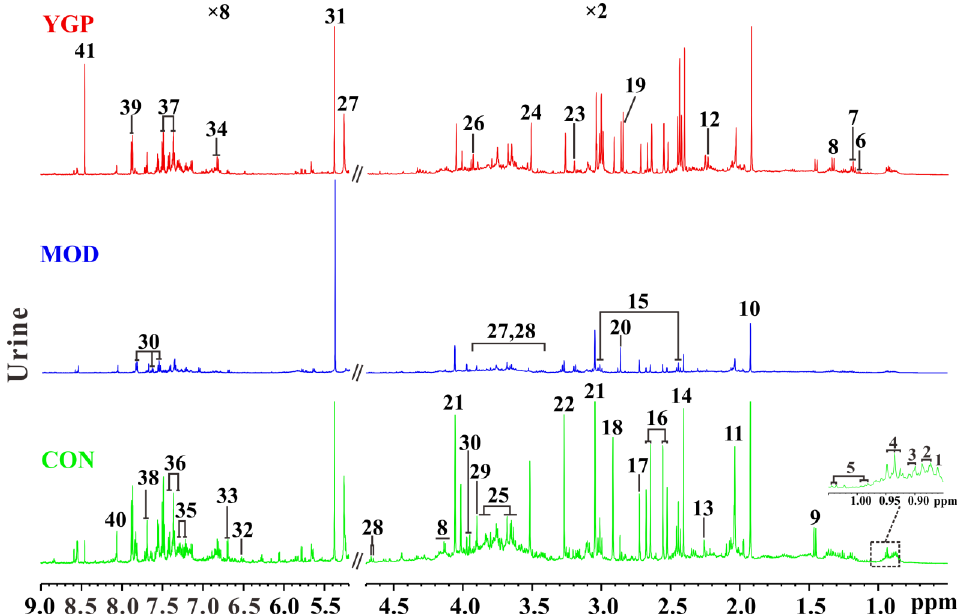
Figure 3. Typical 1 H NMR spectra of urine sample (CON: Control group; MOD: KYDS group; YGP: